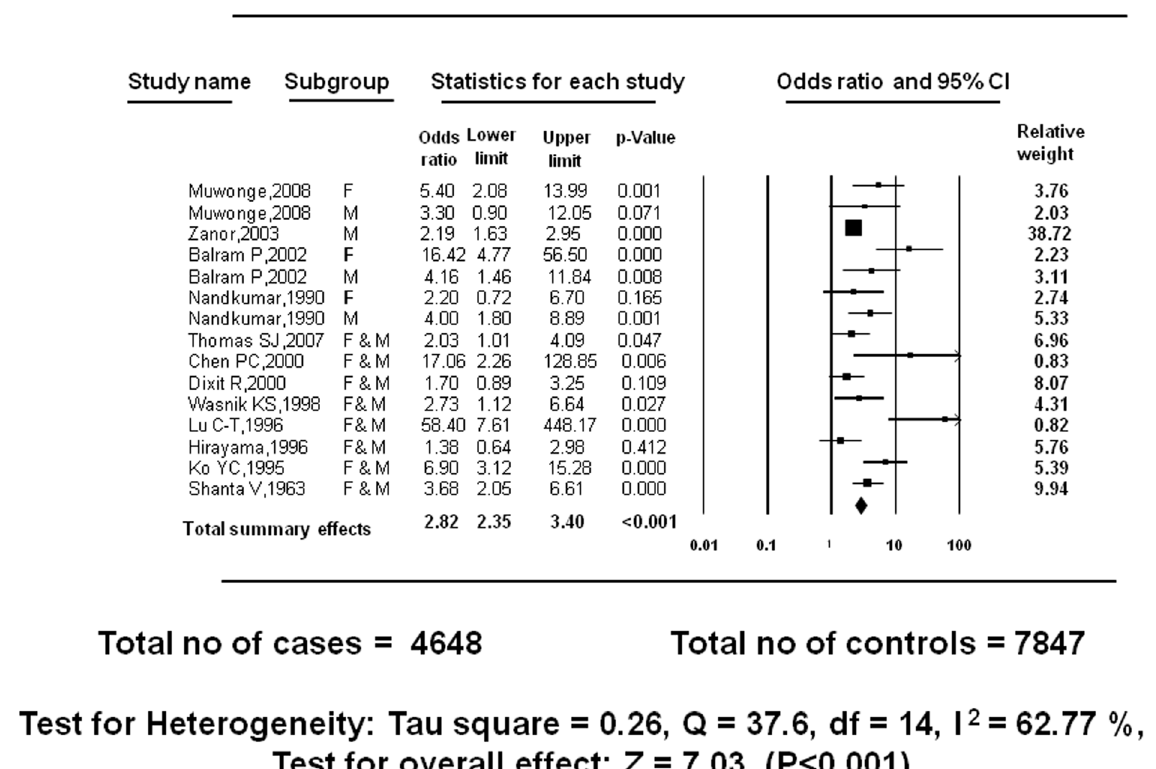
Figure 3. Meta-analysis of case-control studies: BQ without tobacco use and incidence of oral cancer.